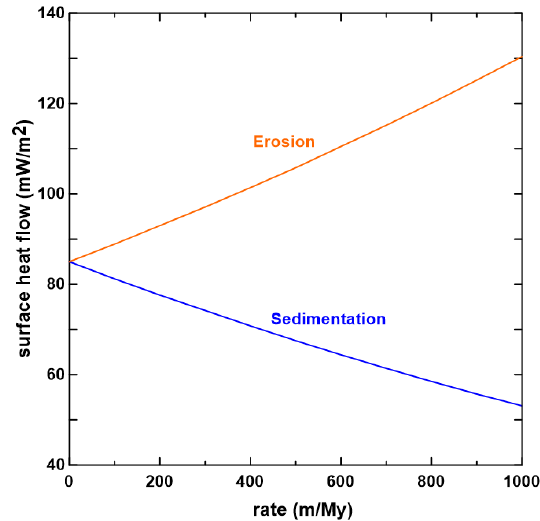
Figure 5. Changes in the surface heat flow in the Menderes Massif for increasing rates of sedimentation (blue line) and ero- sion (orange line). The graphs were prepared using the mod- ules of G. Beardsmore (http://monash.edu/science/about/schools/ geosciences/heatflow/). See Beardmore and Cull (2001) for the for- mulation of the problem. The model assumes extensional activity for the last 5Myr, a background heat flow of 85mWm − 2 , and a thermal diffusivity of 1 × 10 − 6 m 2 s − 1 . Note that these models use a 1-D assumption for